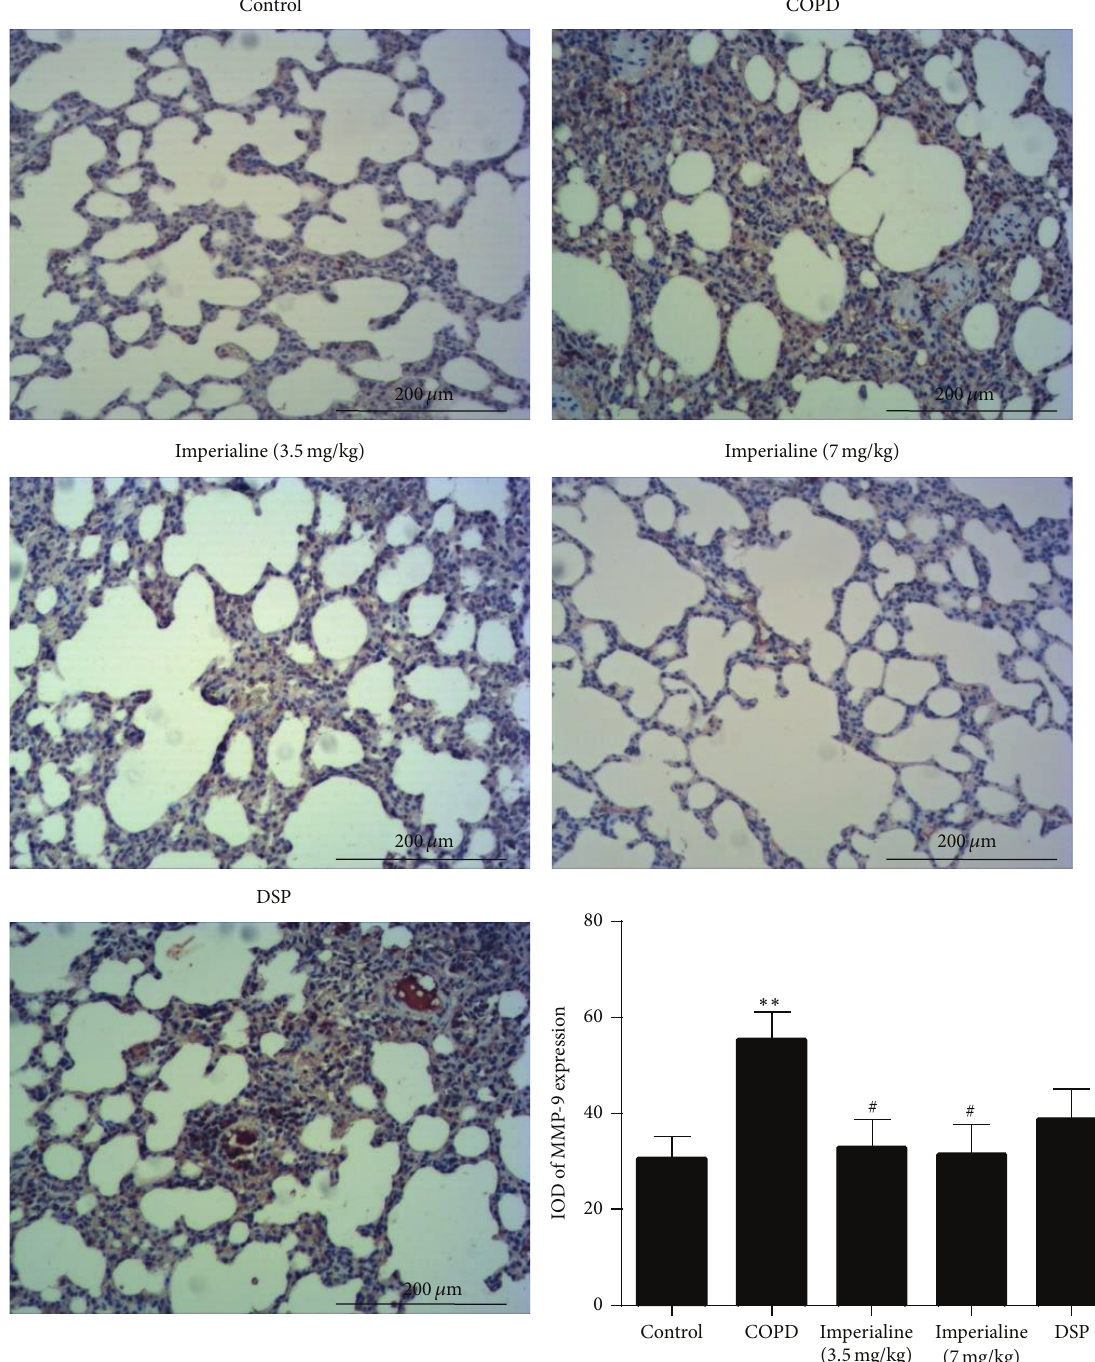
Figure 11: Immunohistochemical staining of MMP-9 in lung tissues of rats in different groups and IOD of MMP-9 expression. Results were expressed as the mean ± SEM ( 𝑛 = 10 ). Significant difference compared with the control group was designated as ∗∗ 𝑃 < 0.01 . Significant difference compared with the COPD group was designated as # 𝑃 < 0.05